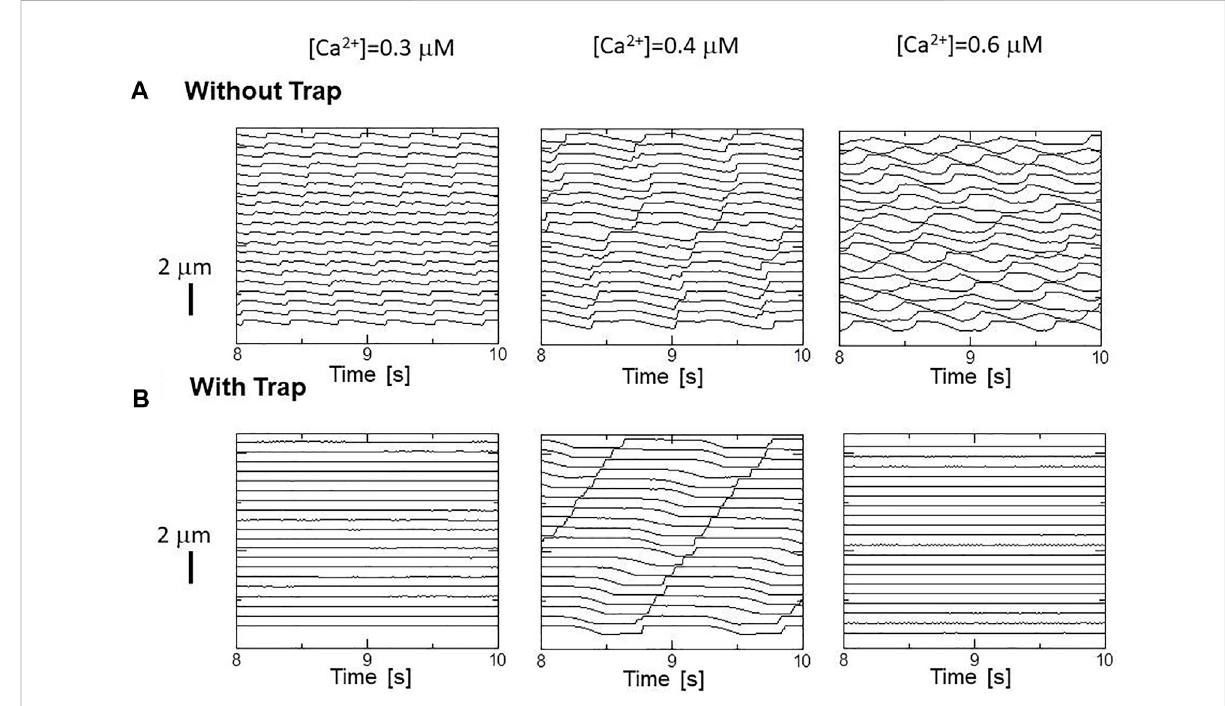
FIGURE 10 Sarcomere length changes in the myo fi bril model under activations with different constant calcium concentrations [Ca 2+ ] = 0.3 μ M (left), 0.4 μ M (center), 0.6 μ M (right), for (A) the no-trap model and (B) the trap